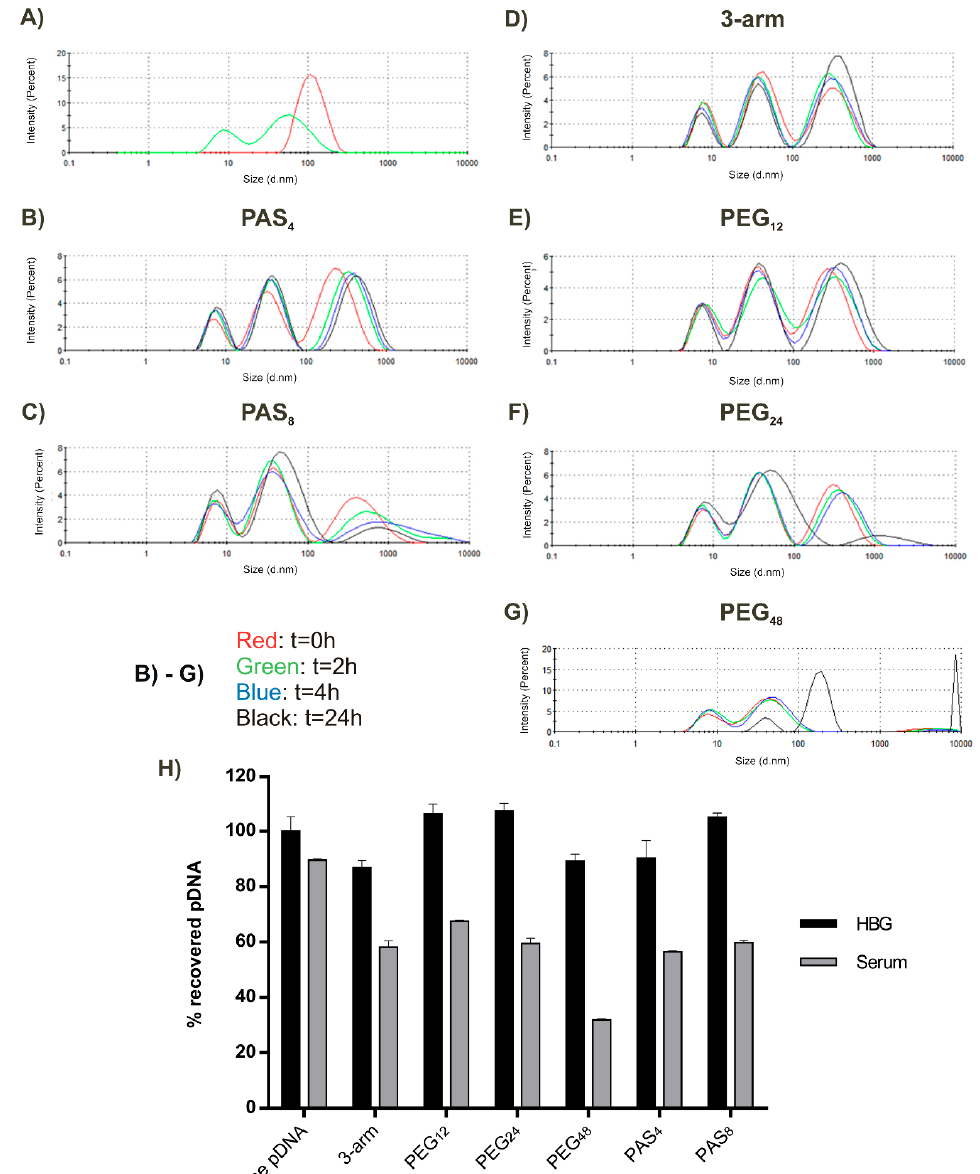
Figure 3. ( A ) DLS measurements of 90% fetal bovine serum (FBS, green) and pDNA polyplexes of the three-arm oligomer in HBG (red) as references to discriminate polyplex and serum peaks; ( B – G ) Display behavior of polyplexes with indicated oligomers in 90% FBS over time. In ( H ), the amount of recovered pDNA of polyplexes containing Cy5-labeled pDNA after treatment with 3500 IU heparin is displayed after incubation with FBS for 30 min; HBG-treated polyplexes served as control.